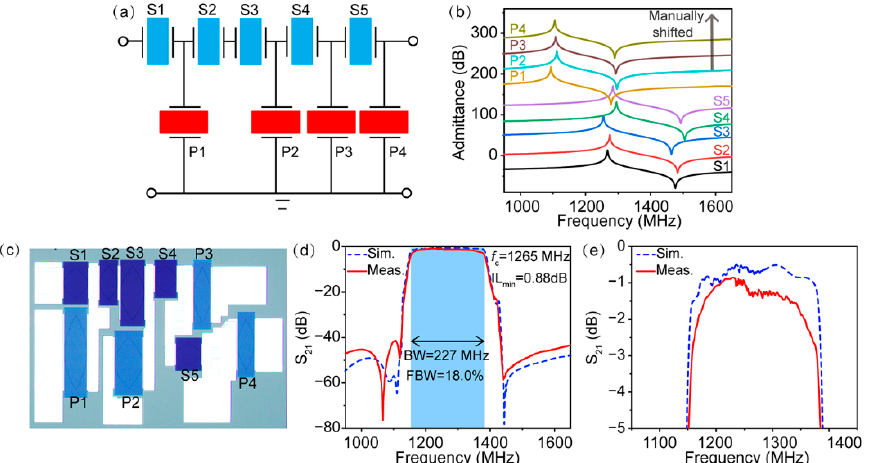
Figure 5. ( a ) The filter topology; ( b ) simulated admittance curves of series and shunt resonators. The curves were manually shifted by 40 dB for better comparison; ( c ) optical microscope of the fabricated filter; ( d ) simulated and measured frequency responses of the filter; ( e ) zoomed-in simulated and measured frequency responses of the filter. Table 1. The design parameters of the SAW filter using the first IDT thickness-modulated configuration.